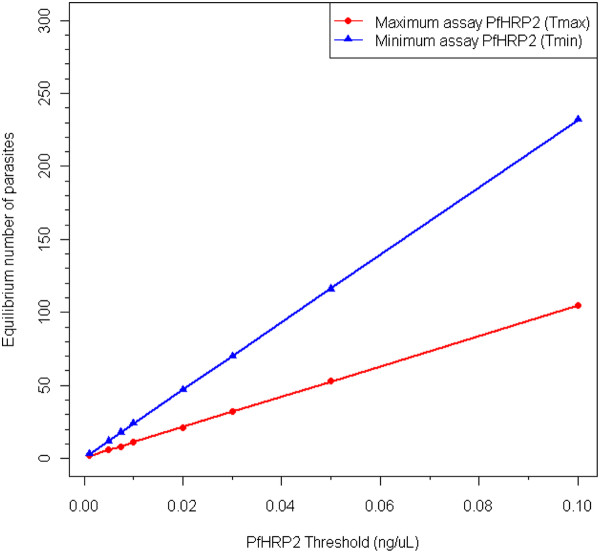
Predicted minimum number ofP. falciparumparasites required to maintainPfHRP2 concentration above a specified threshold. Data are presented for the fitted maximum circulating model (Tmax, red) and minimum circulating model (Tmin, blue).